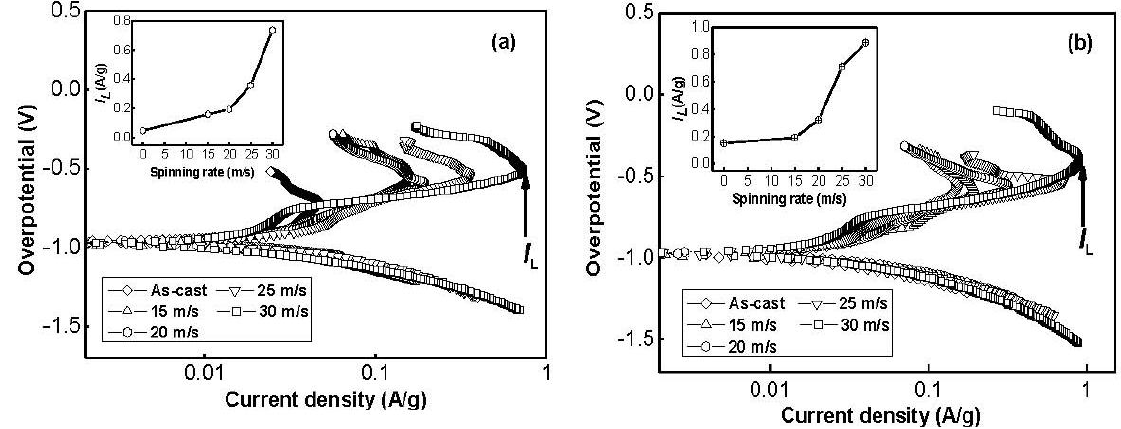
alloy; ( b ) Co 0.1 0.4